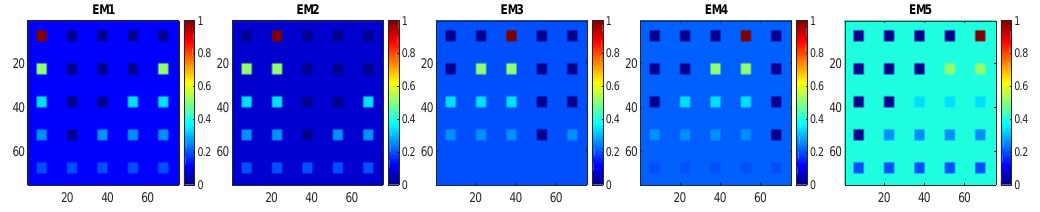
Figure 4. True fractional abundances of endmembers of